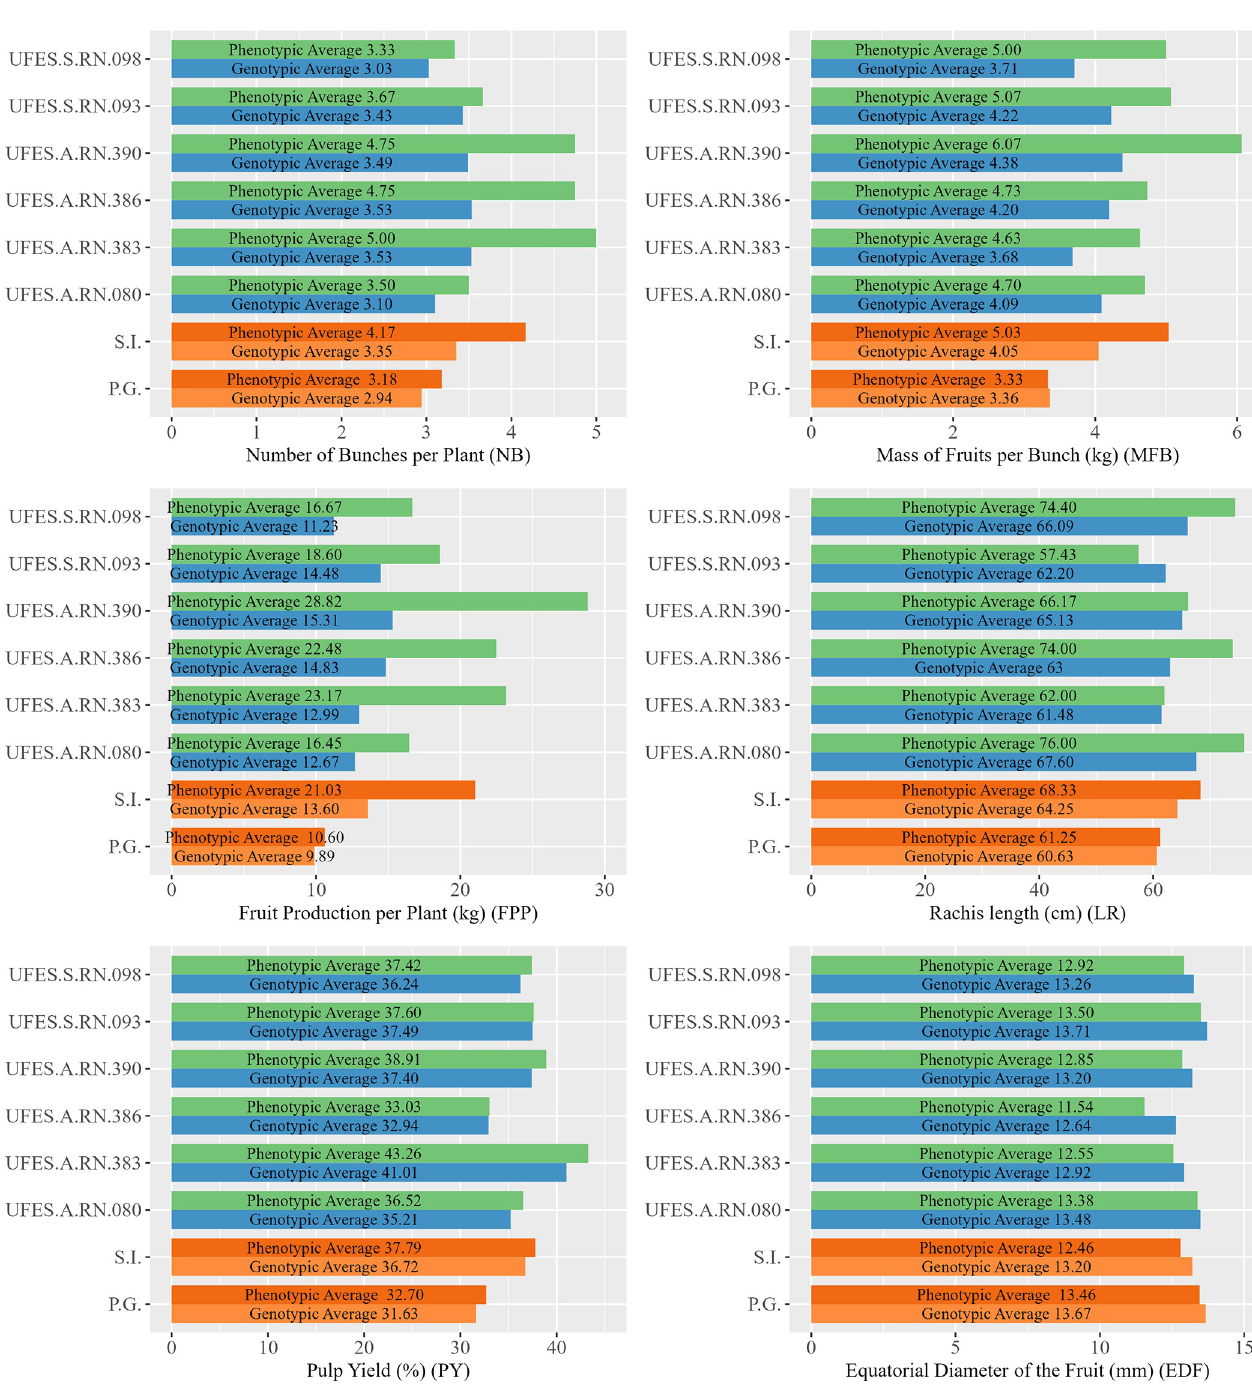
Fig 4. Phenotypic means observed in the field and GEBV’s + mean of selected genotypes and general population. S.I.: commercial seed donor population, P.G.: general population.